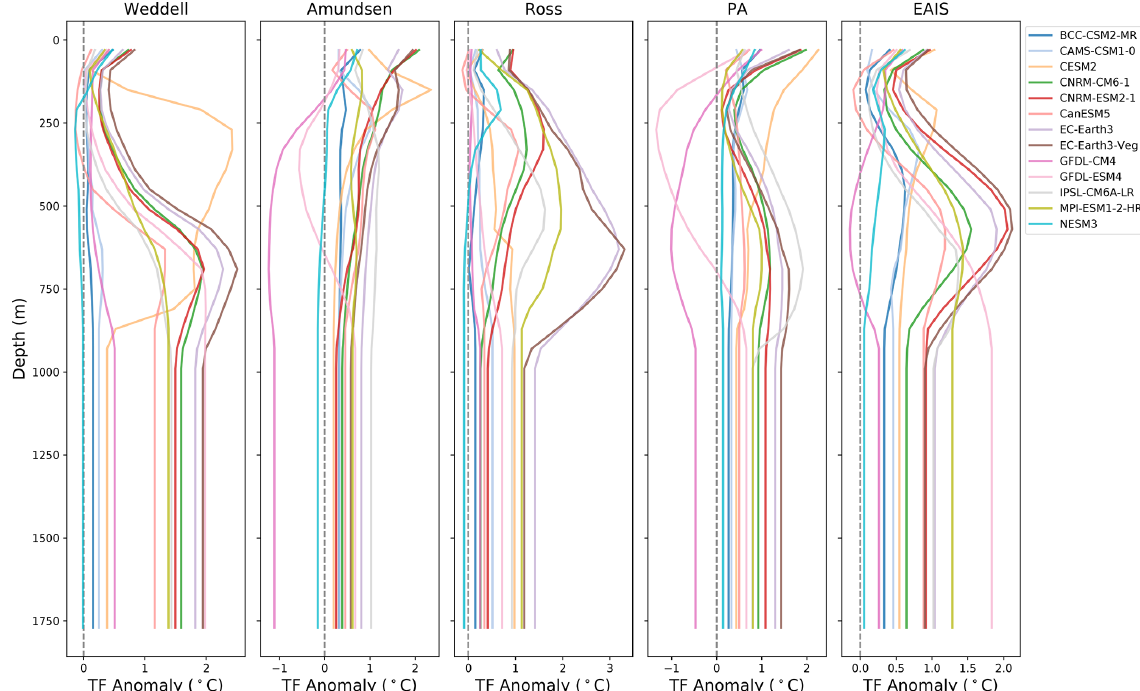
Figure 7. Final thermal forcing (TF) anomaly profile for each basin. The TF anomaly begins at zero at all ocean levels. The anomaly grows linearly at each level until it reaches the mean 2090–2100 anomaly. After this, the 2090–2100 mean value is held constant for another 400